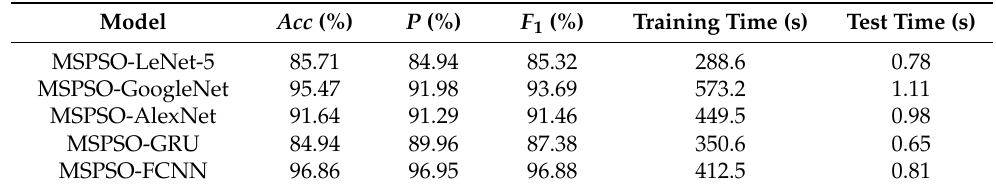
Table 8. Comparison between